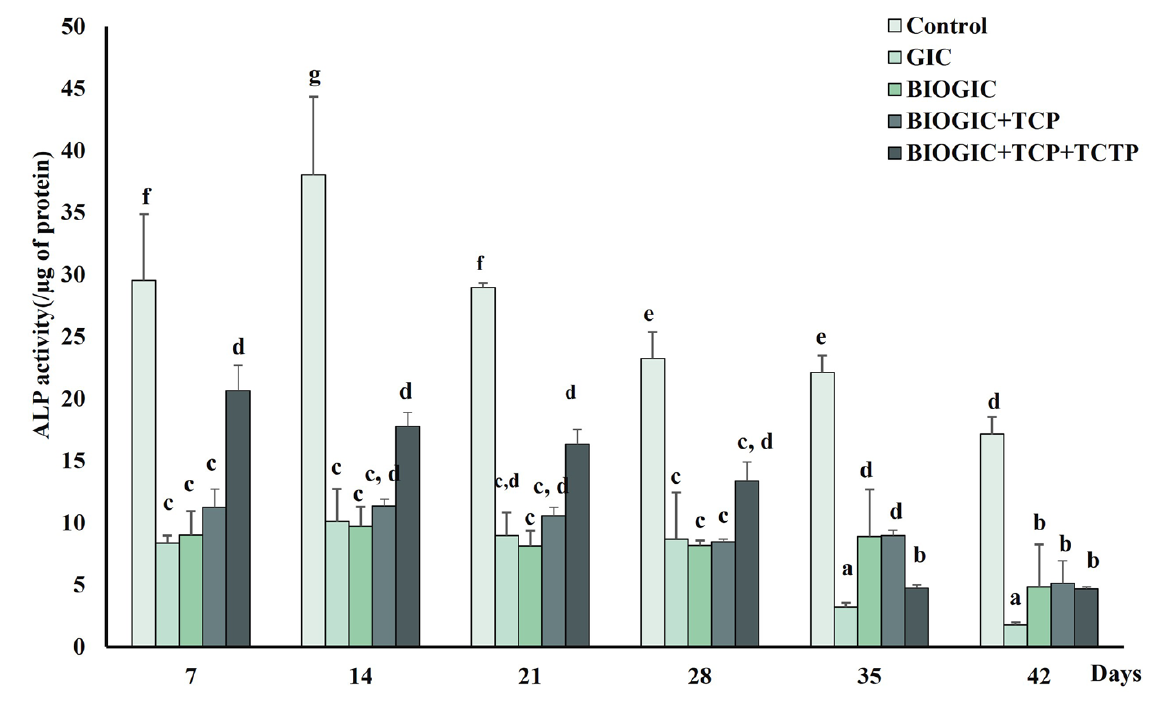
Figure 9. Odontogenic differentiation potential of hDPSCs. ALP activity was used to evaluate cell differentiation after culturing hDPSCs with each specimen for 7, 14, 21, 28, 35, and 42 days. Data are represented as mean ± SD. Different lowercase letters represent significant difference at p < 0.05 ( n = 6 in each group).